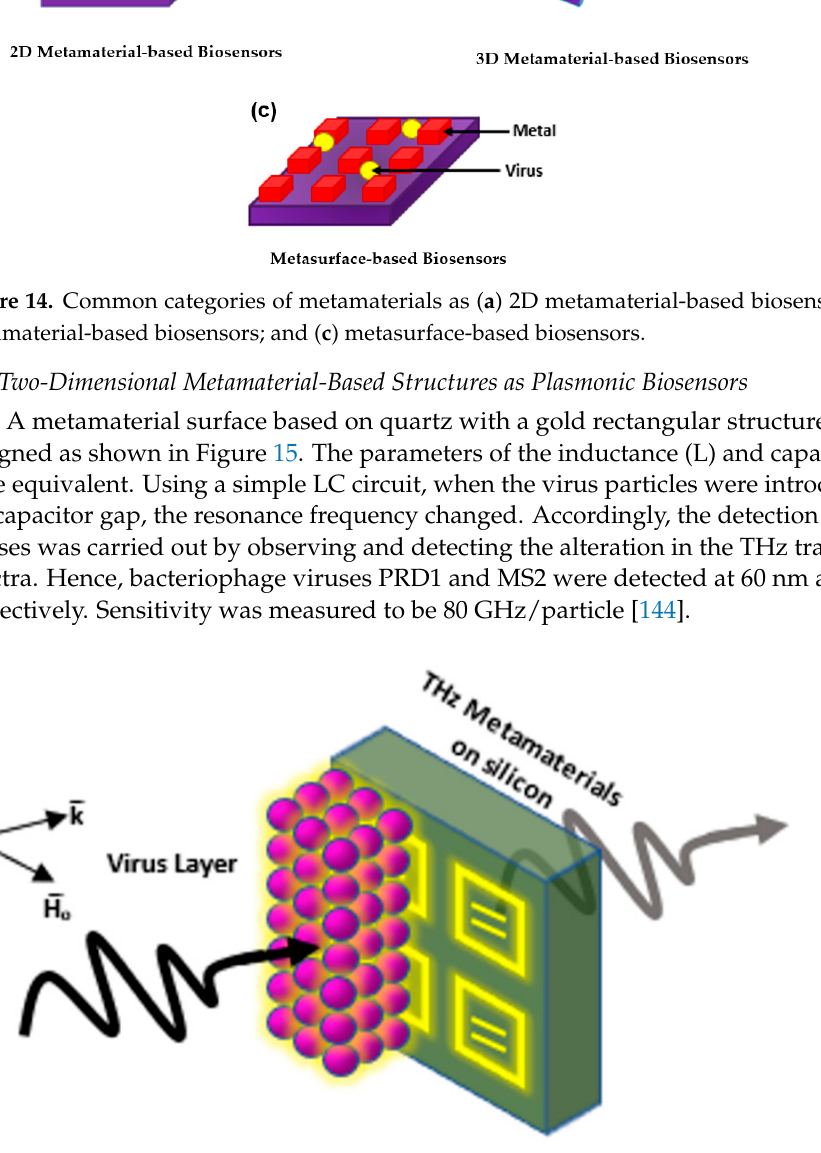
Figure 14. Common categories of metamaterials as ( a ) 2D metamaterial-based biosensors; ( b ) 3D metamaterial-based biosensors; and ( c ) metasurface-based biosensors.